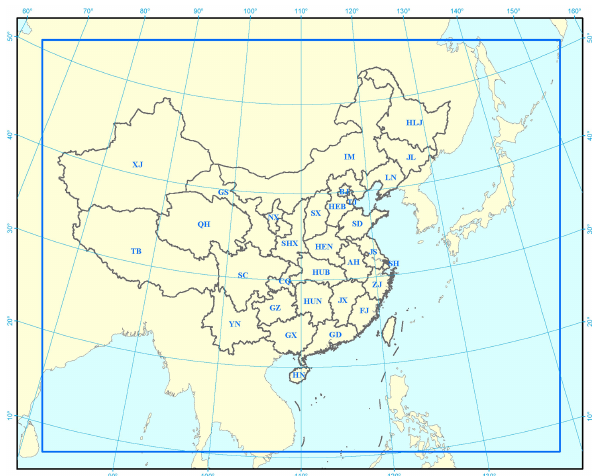
Figure 2. Simulation domain over mainland China (27km × 27km resolution, 182 × 232 grid cells). The 31 provinces are BJ –